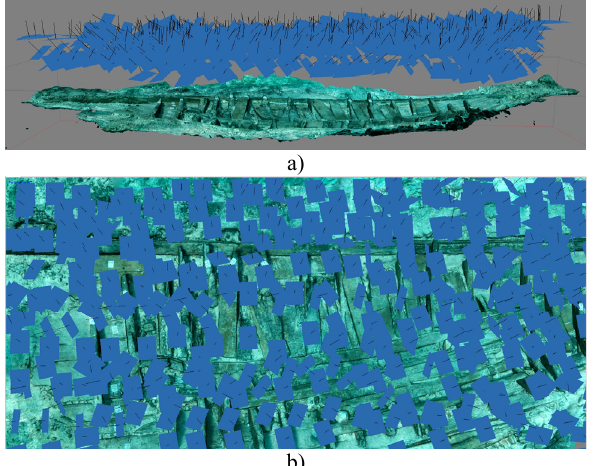
Figure 15. View of the different camera locations: a) side view of the texture mapped 3D model, b) top view.